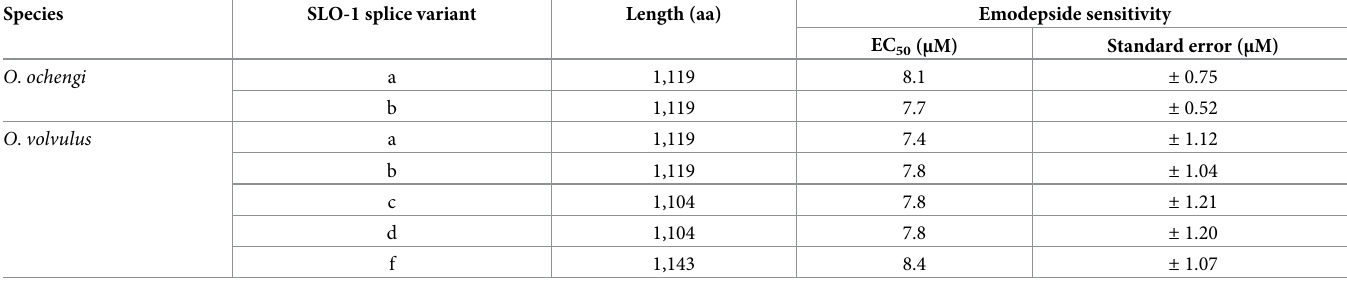
Table 2. Emodepside sensitivity of Onchocerca ochengi and Onchocerca volvulus SLO-1 splice variants. Two O . ochengi and five O . volvulus splice variants were heter- ologously expressed in Xenopus laevis oocytes and exposed to increasing concentrations of emodepside. Concentration-dependent changes in electric current were mea- sured and concentration-response curves were generated. The EC 50 value is the emodepside sensitivity of each SLO-1 splice variant.